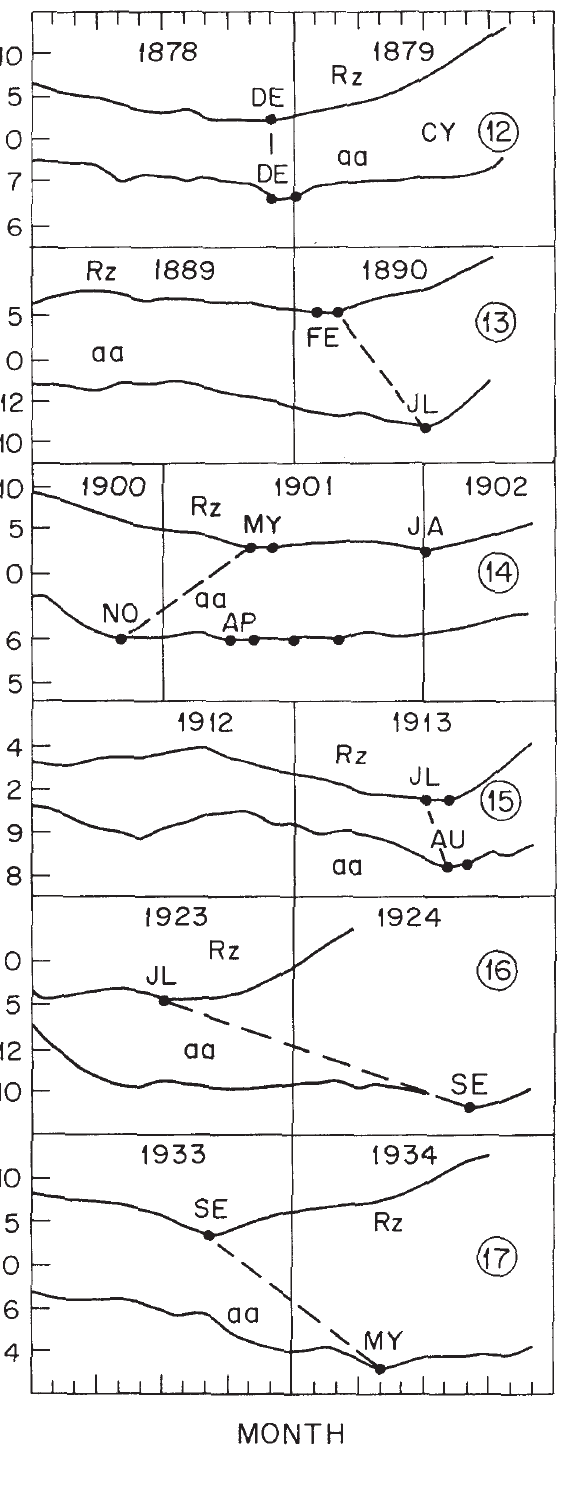
Fig. 1. Plots of the 12-month moving averages of sunspot number Rz and geomagnetic index aa during years of minima of sunspot cycles, (a) cycles 12–17, (b) cycles 18–23. The dashed line connects Rz (min) to aa (min).